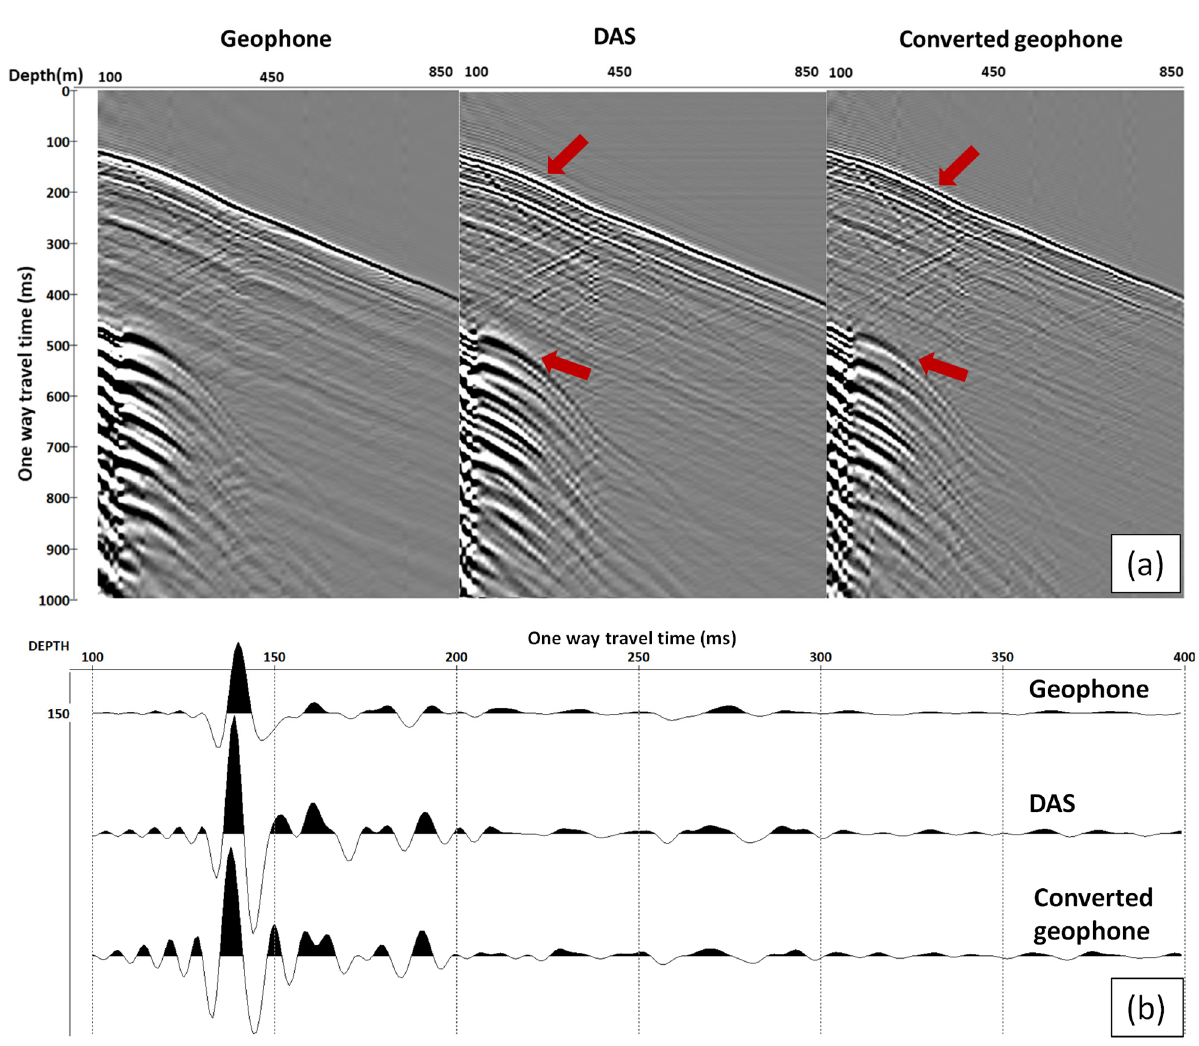
Figure 4. Near-offset example: ( a ) from left to right: gathers of geophone, DAS and converted geophone response; ( b ) from top to bottom: trace at a depth of 150 m of geophone, DAS and converted geophone response. We exclude every second trace from DAS data to match the same receiver interval for geophone/converted Geophone and DAS. The red arrows indicate the difference in phase of P- and S direct waves between recorded DAS and converted geophone data.